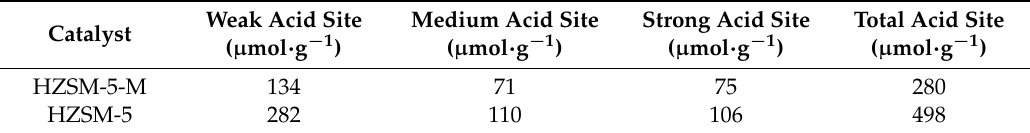
Table 1. Total acidity and acidic site distribution of the HZSM-5-M and HZSM-5 samples 1 .